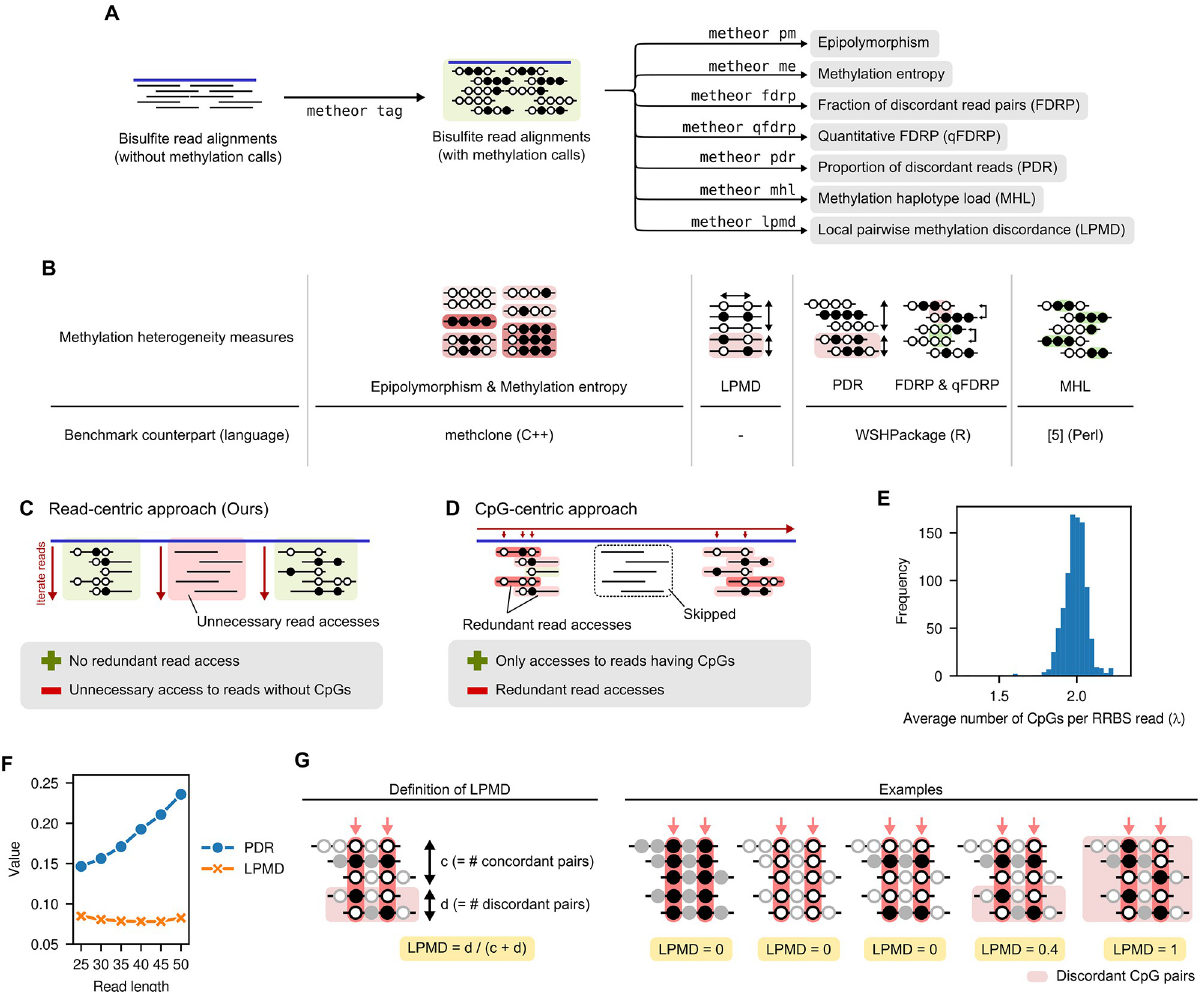
Fig 1. Overview of Metheor. (A) The input for Metheor is bisulfite read alignment tagged with Bismark methylation call strings. Using each of the seven subcommands shown, Metheor computes the corresponding DNA methylation heterogeneity measure. If reads were aligned with a tool other than Bismark, Metheor can still add tag for methylation call string with metheor tag subcommand to make alignment file compatible for Metheor run. (B) Schematic diagram for DNA methylation heterogeneity measures and benchmark settings in this study. [5] denote the Perl script provided by the authors along with the article proposing the utility of MHL. (C, D) Schematic diagram illustrating (C) read-centric algorithm and (D) CpG-centric algorithm for the computation of DNA methylation heterogeneity. The advantages (plus symbol) and disadvantages (minus symbol) are shown below the diagrams. (E) Distribution of the average number of CpGs per sequencing read for the RRBS data from 928 CCLE cell lines. (F) Genomewide average levels of proportion of discordant reads (PDR) and local pairwise methylation discordance (LPMD) against varying read lengths. (G) Schematic illustration for the definition of local pairwise methylation discordance (LPMD) and examples. The proportion of reads having different DNA methylation states for a pair of CpGs (red arrows) are